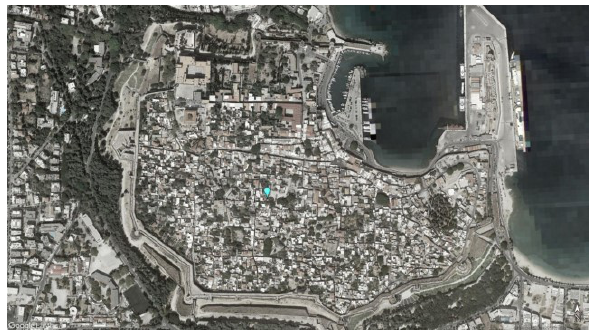
Figure 1. The position of the church in the Medieval City of Rhodes.